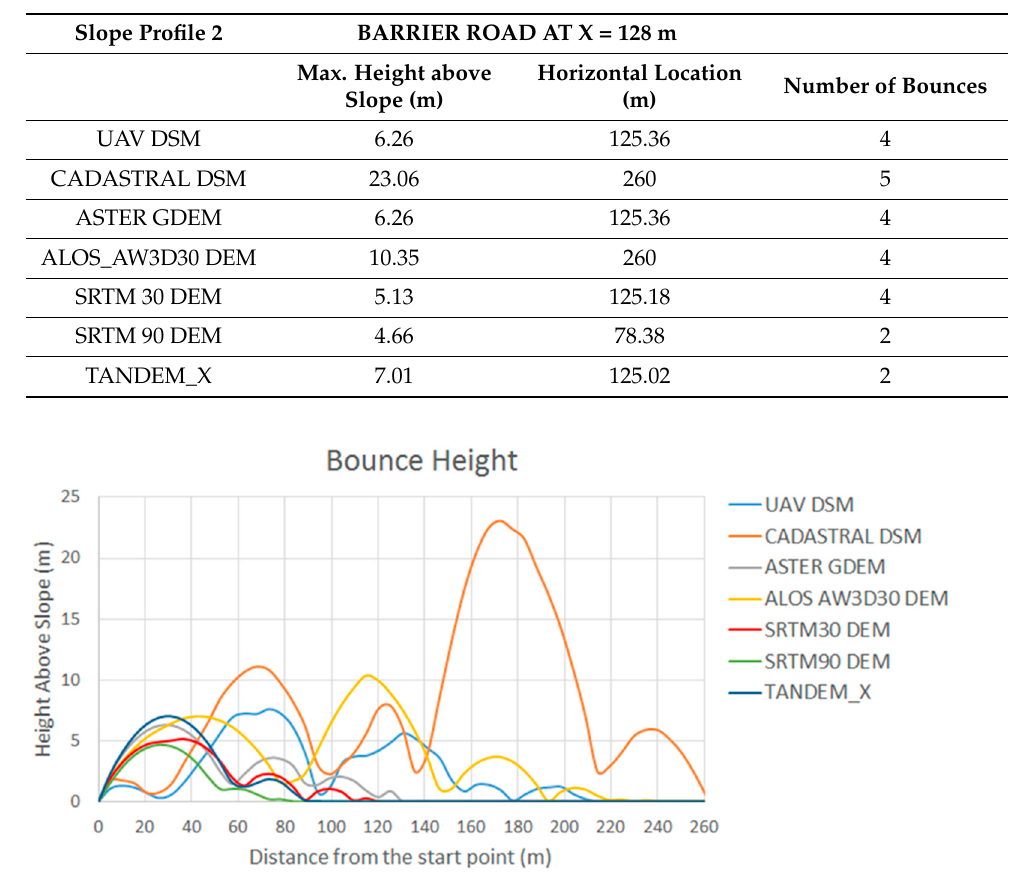
Figure 13. Bounce height for the 2nd slope profile.